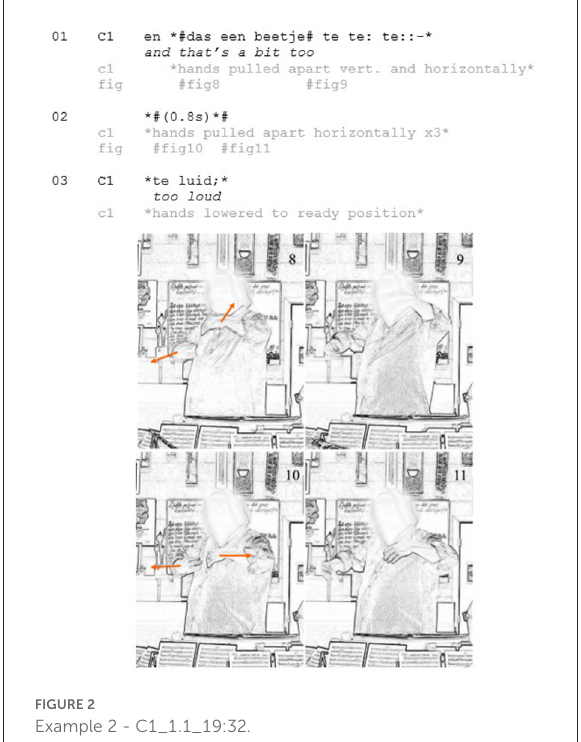
FIGURE2 Example 2 -